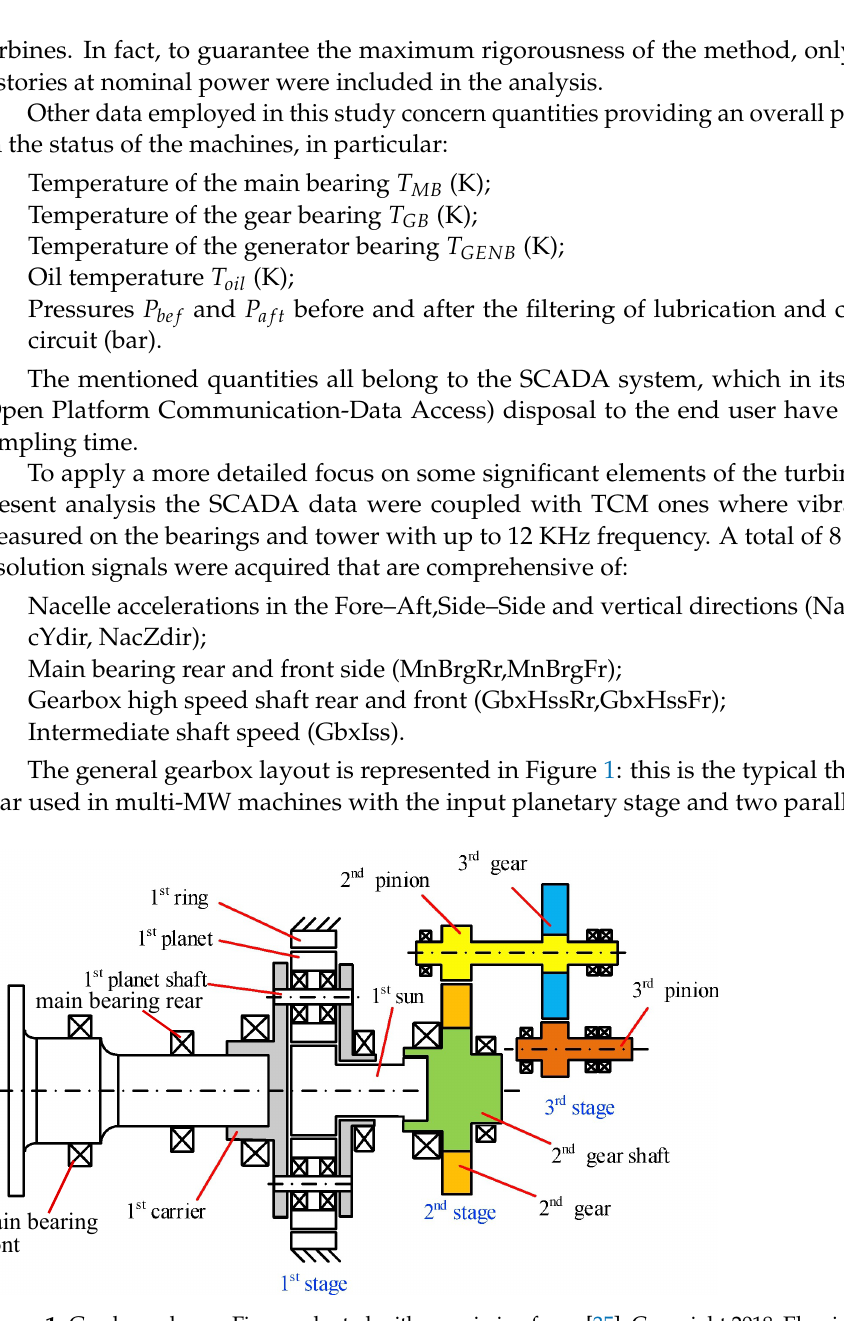
Figure 1. Gearbox scheme. Figure adapted with permission from [35]. Copyright 2018, Elsevier,